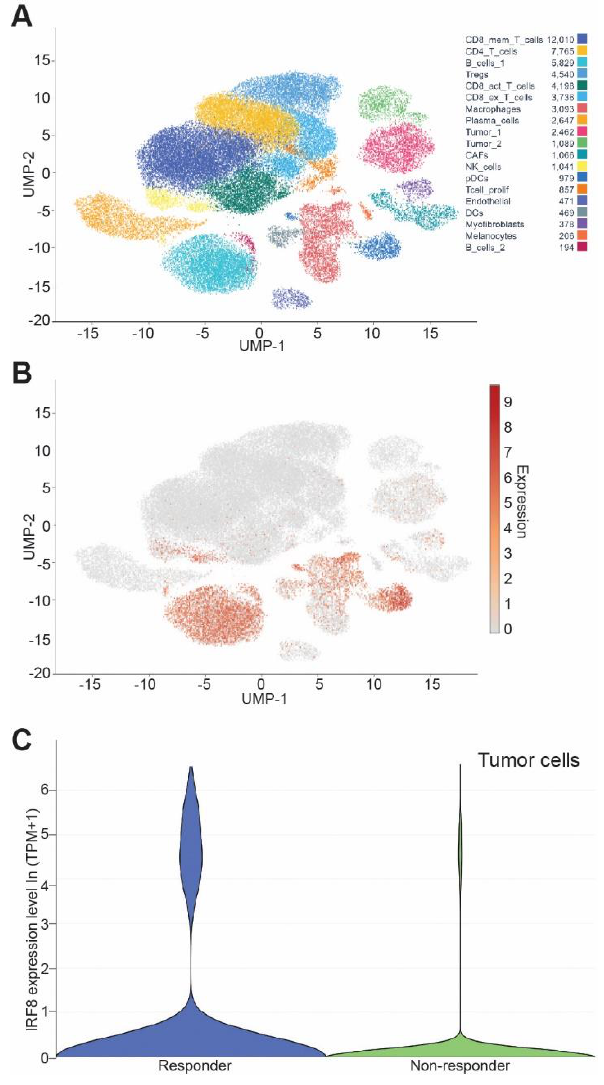
Figure 7. Tumor cell IRF8 expression level correlates with cancer patient response to anti-PD-1 im- munotherapy. ( A ) UMAP dimensionality reduction plot of cell types in human melanoma from GEO dataset GSE115978. ( B ) UMAP dimensionality reduction plot of expression level of Irf8 in tu- mor resident cells. ( C ) Violin plot of IF8 mRNA level in tumor cells in the responders and non- responders of melanoma patients after nivolumab immunotherapy.